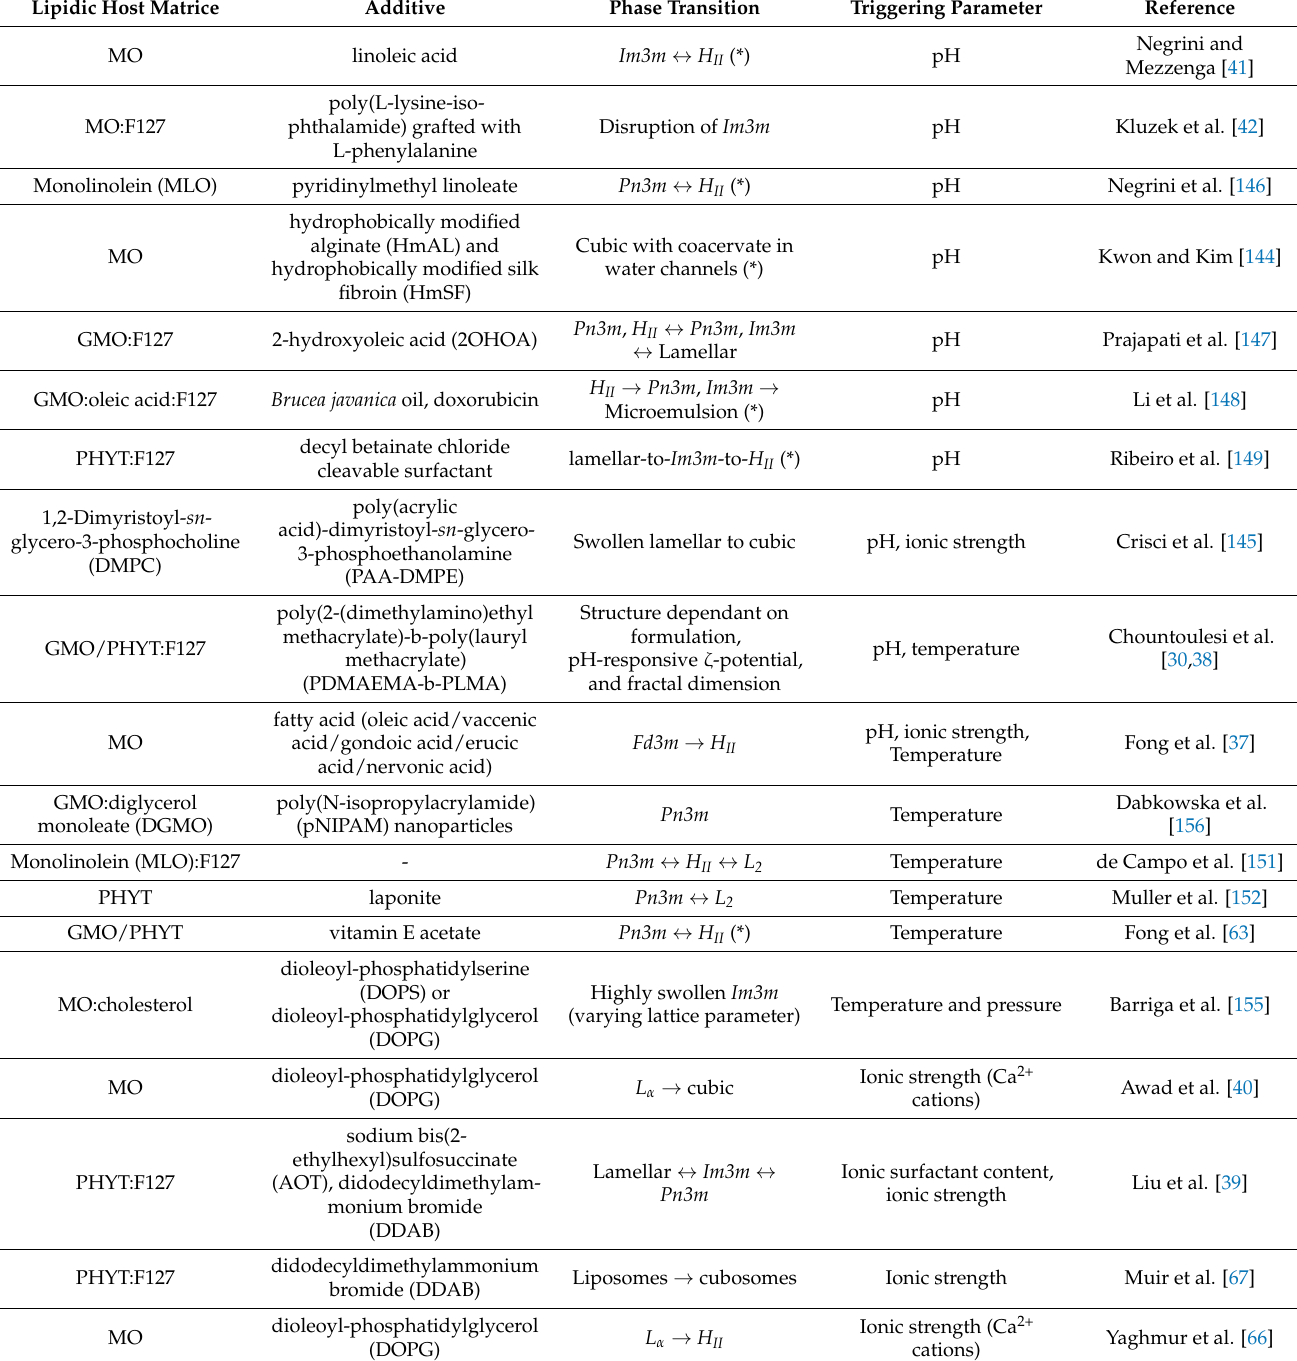
Table 2. Summary of the reported case studies with regards to the influence of environmental and formulation parameters in the internal nanostructures of non-lamellar LLCN, including the stimuli-responsive